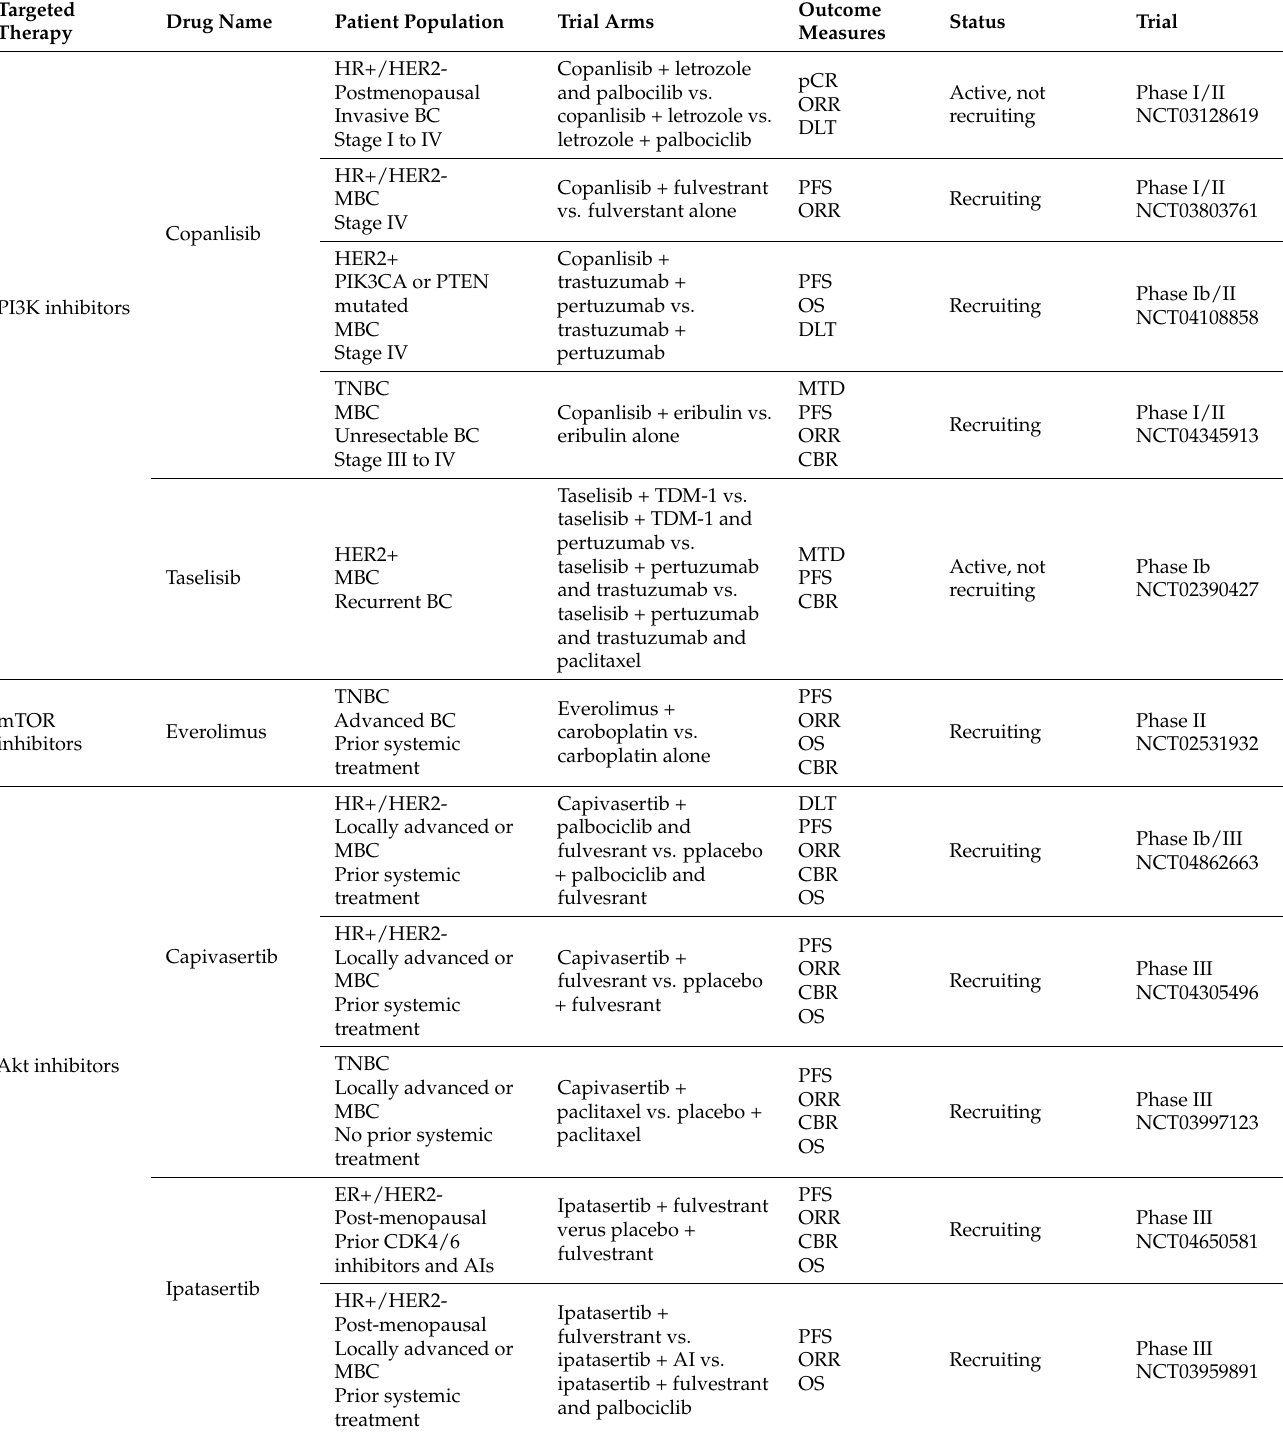
Table 4. Ongoing clinical trials on emerging therapies for BC treatment for all BC molecular subtypes. Targeted